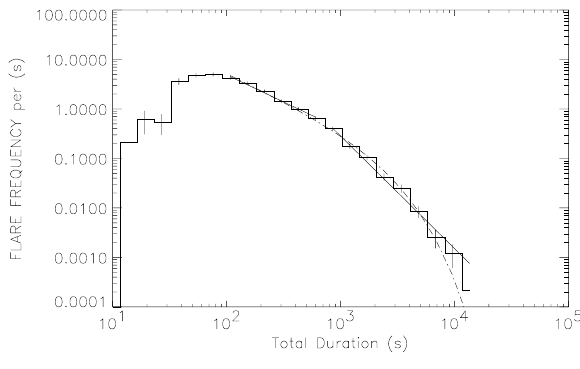
Fig.13. Scatter plot between the elapsed time 4 T since previous burst and the burst peak count rate for bursts associated with the same active region. This plot is obtained by the accumulation of 19 plots performed onseveralactiveregions.Thetrianglesindicatethattheprecedingevent had a large peak count rate ( 1000 c/s).